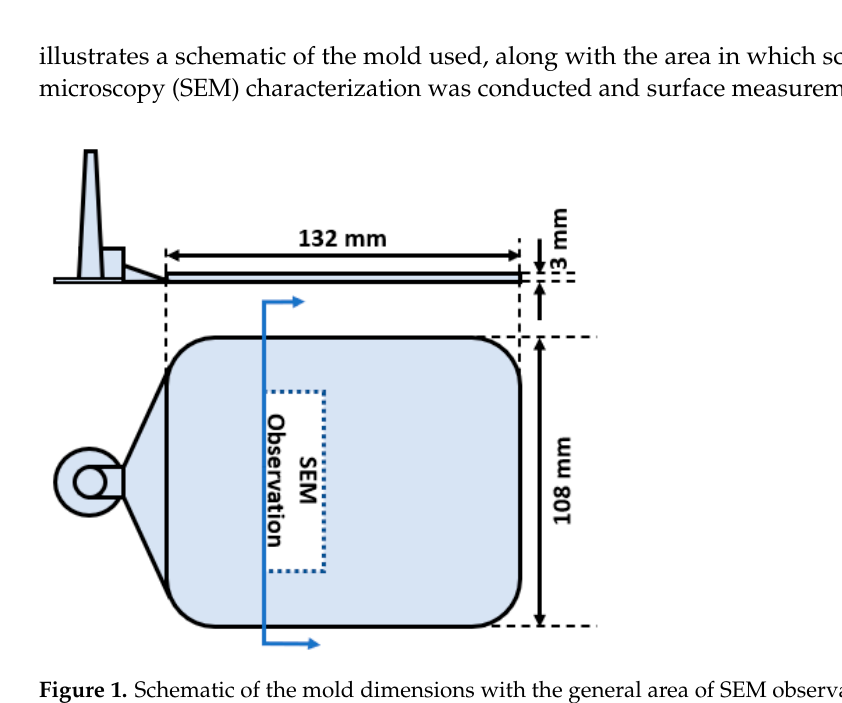
Table 3. MO-FIM molding processing